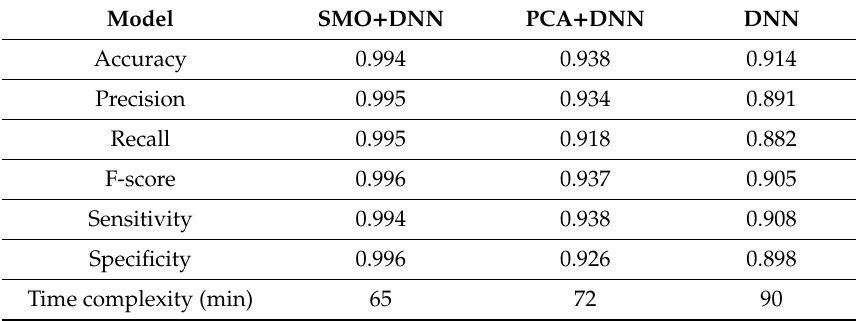
Table 3. Detailed performance evaluation of the SMO-DNN using